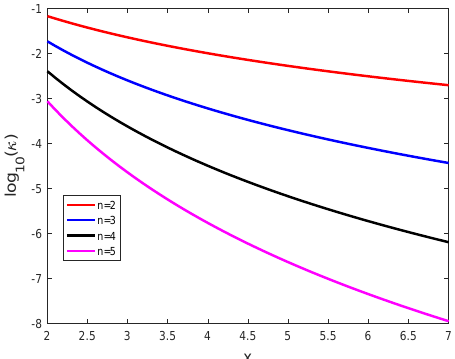
( κ ( x )) versus x . 10